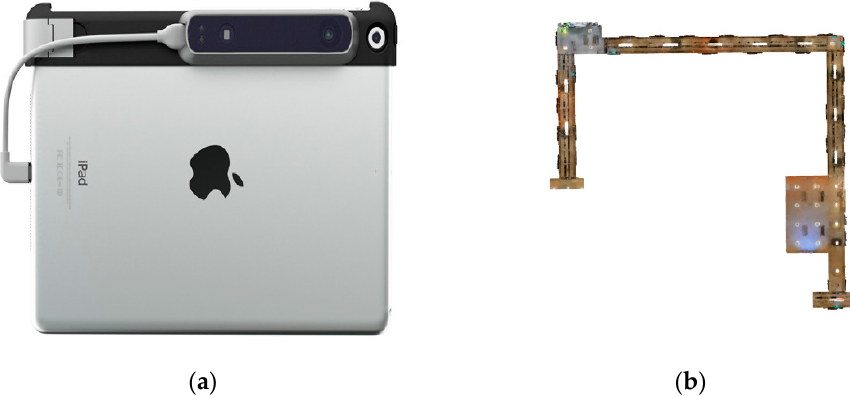
Figure 10. Experiment device and ground truth. ( a ) iPad with a structure sensor; ( b ) Ground truth by NavVis M6.